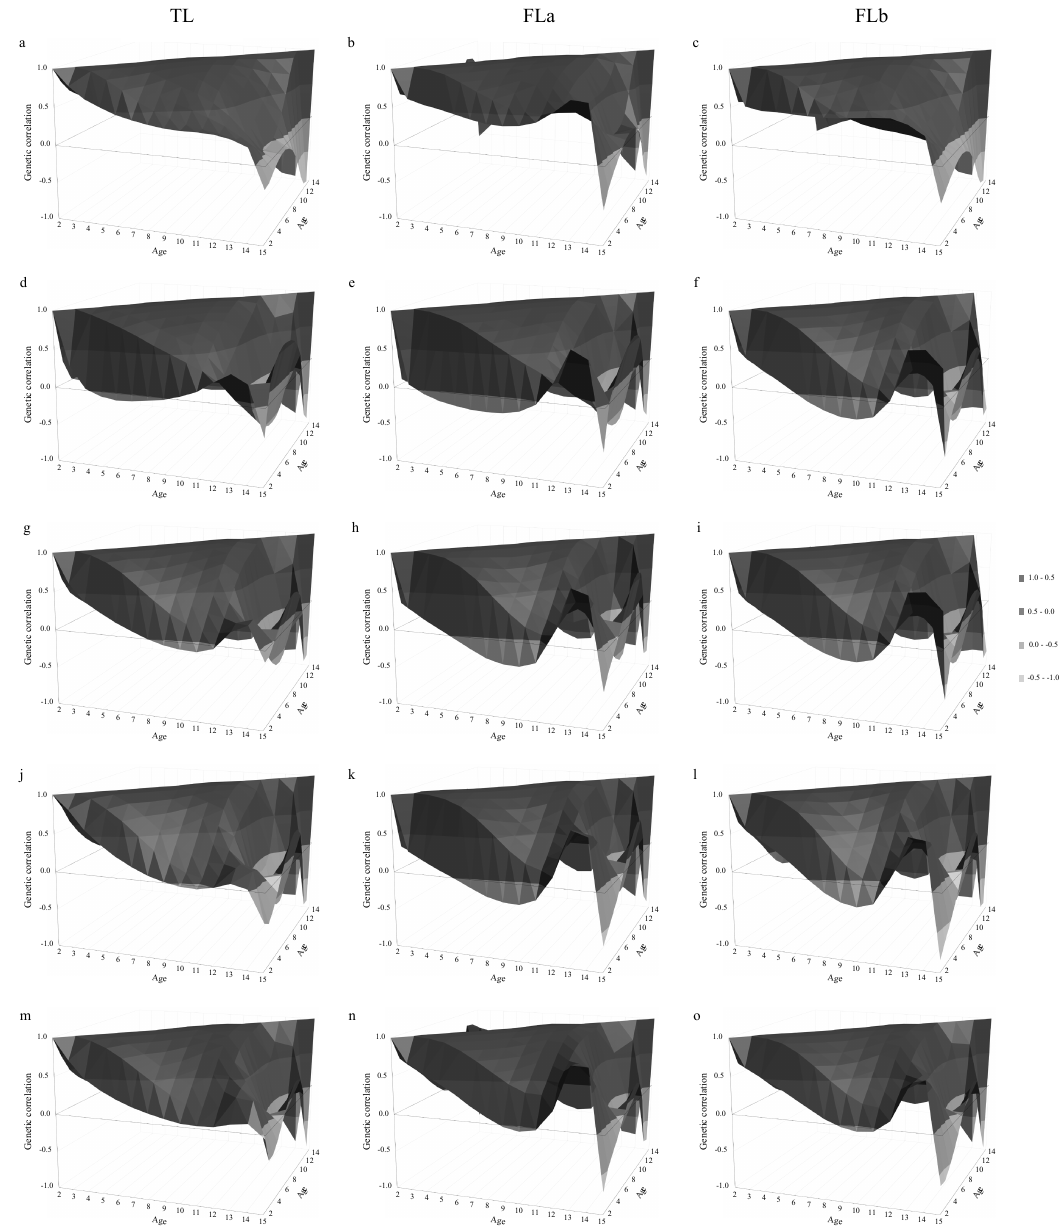
Figure 4. Genetic correlations estimated across ages, for all groups of known culling reason and longevity definitions. The groups of culling reason are: natural death ( a – c ); structural problems ( d – f ); disease ( g – i ); fertility ( j – l ); and performance ( m – o ). The longevity definitions are: traditional longevity (TL); functional longevity assuming 0 after the cow was culled or if the cow did not record a calf at the specified age (FL a ); and functional longevity assuming 0 only after the cow was culled, and missing records when no information of calving was found at the specific age (FL b ), respectively.